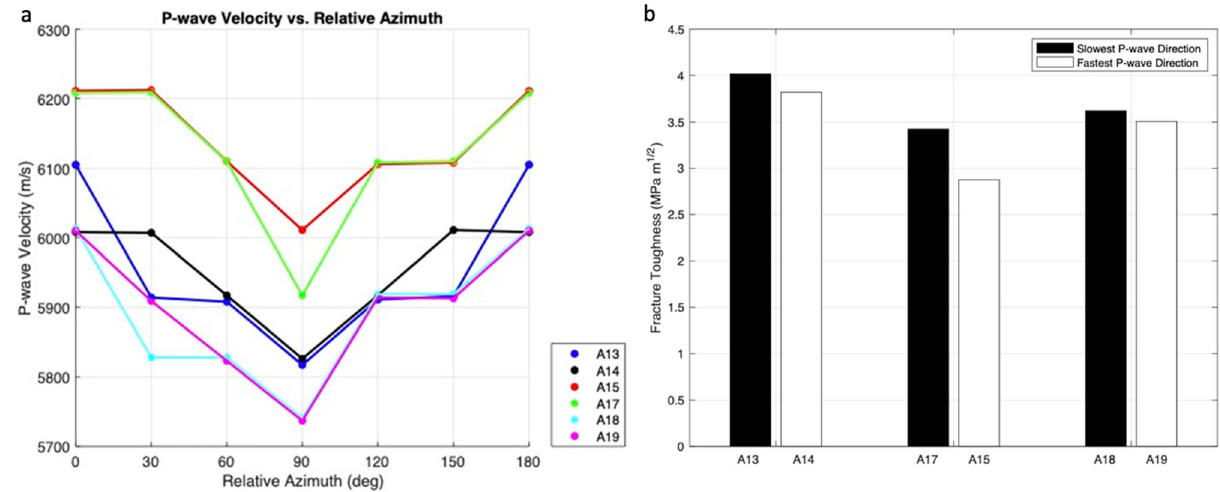
Figure 8. ( a ) P-wave velocity as a function of direction of six amphibolite discs without notches. Relative azimuth is based on fastest direction. ( b ) Fracture toughness values for pairs of amphibolite discs whose velocity variations with notch direction are